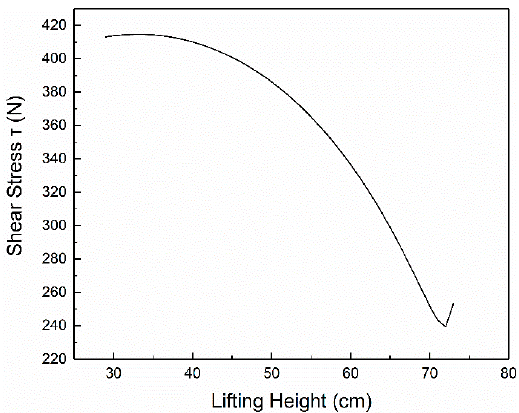
Figure 4. The relationship between σ and h . Int. J. Environ. Res. Public Health 2020 , 17 , x FOR PEER REVIEW